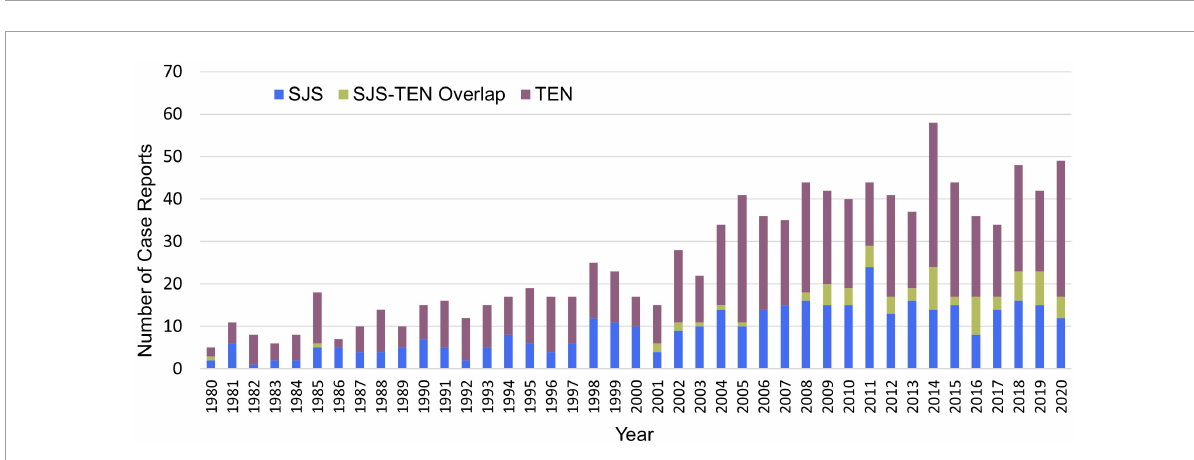
FIGURE3 Distribution of Stevens-Johnson syndrome (SJS), toxic epidermal necrolysis (TEN) and SJS-TEN overlap case reports from PubMed/MEDLINE by publication year.